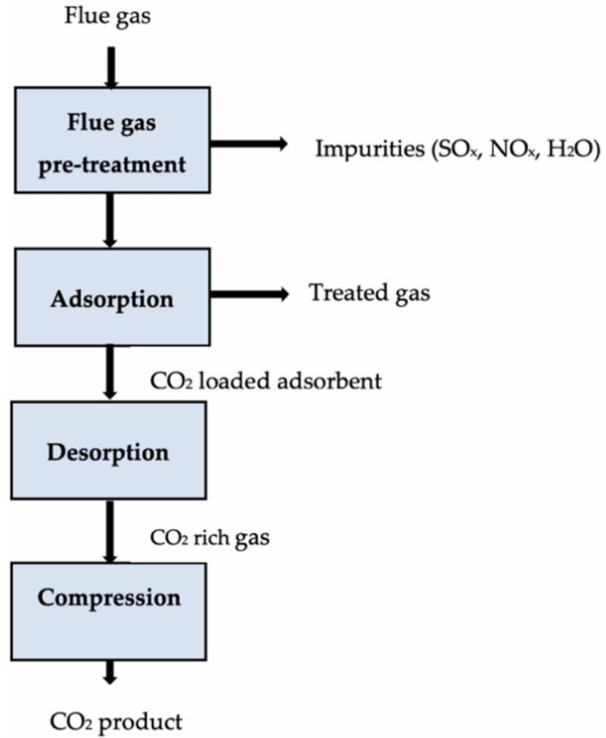
Figure 4. Schematic of an adsorption carbon capture process [110].